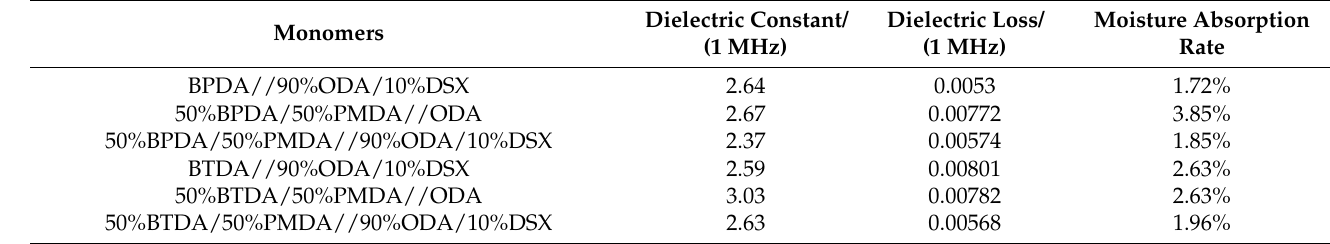
Table 7. Dielectric properties and hygroscopicity of PI films in groups 2 and